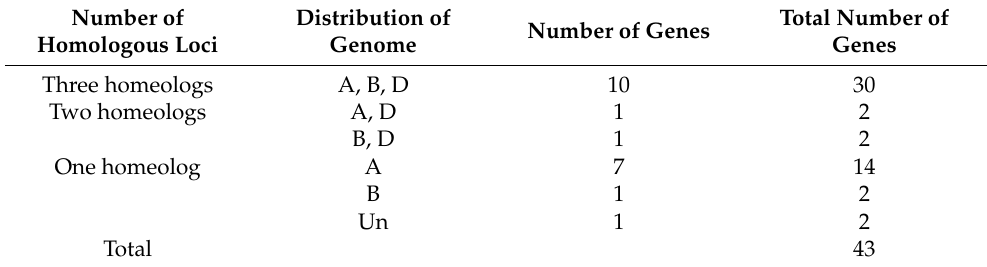
Table 2. The subgenome distribution of TaTUA and TaTUB homeologs. Number of Distribution Homologous Loci